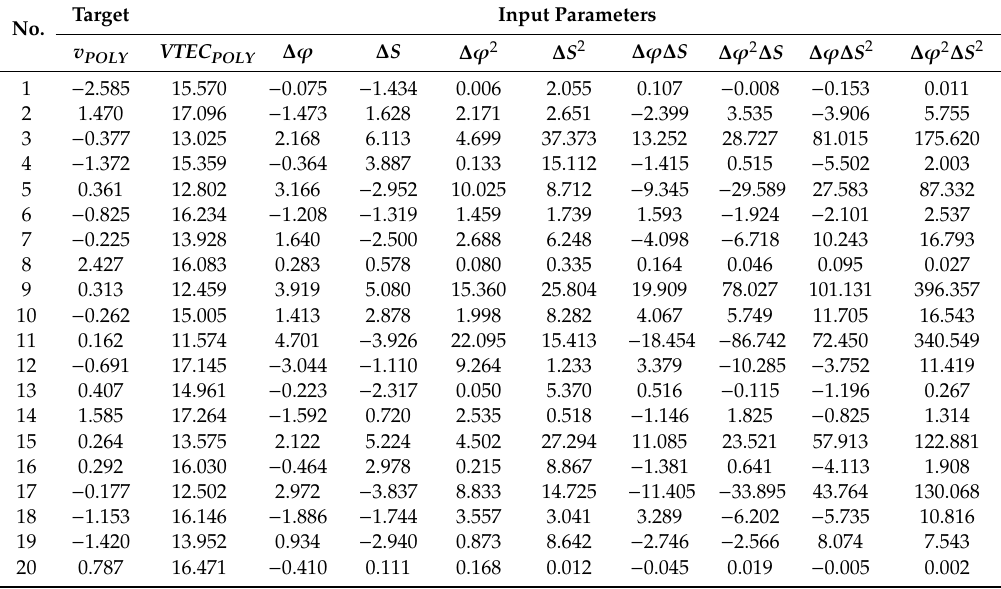
Table 1. Part of Support Vector Machine (SVM) training samples.